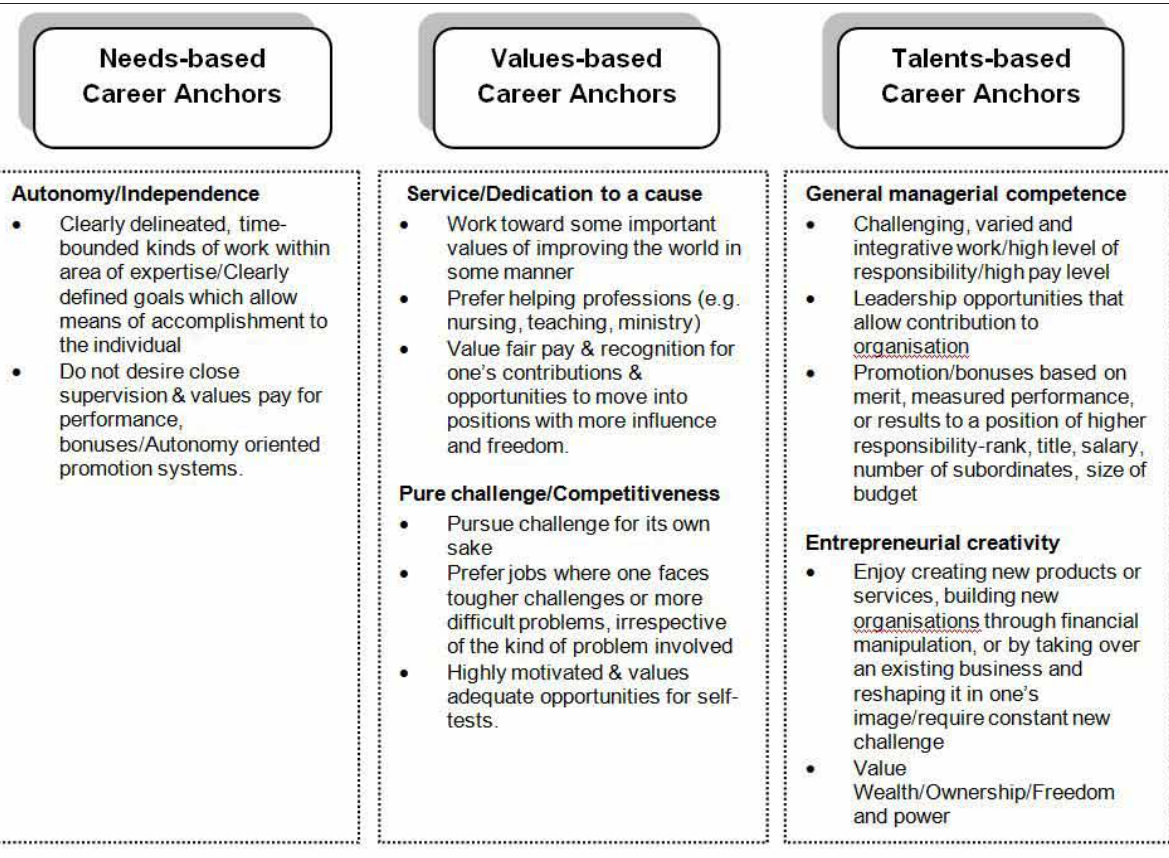
FIGURE 1 Five-factor career orientations